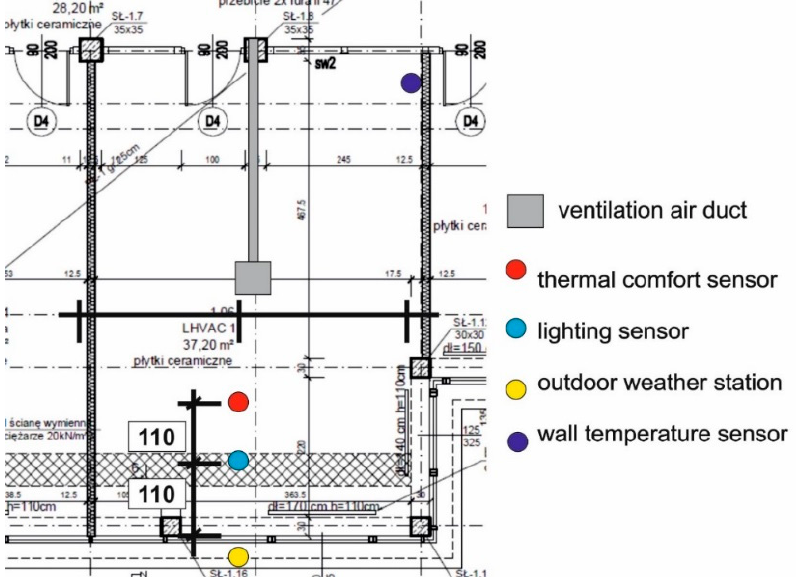
Figure 4. Arrangement of sensors in rooms P1.06 and P2.04.